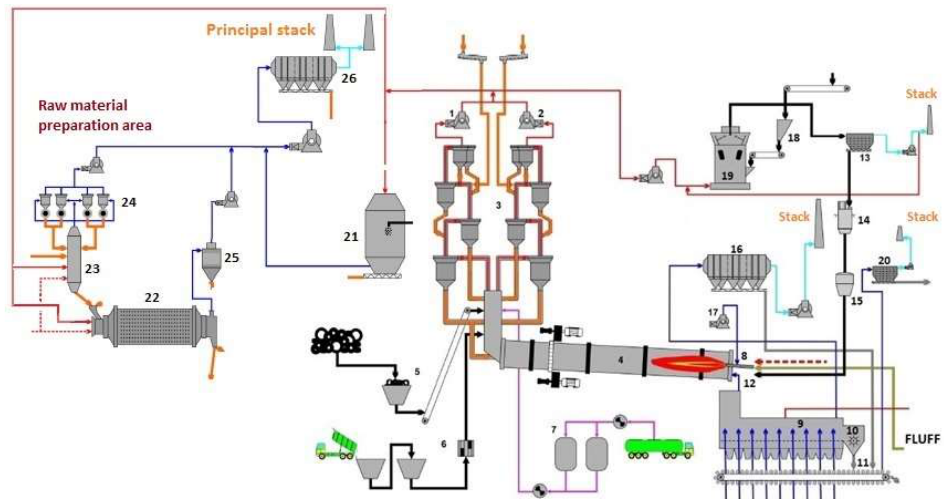
Figure 1. Simplified clinker diagram using raw materials and alternative fuels. 1. fan branch A; 2. fan branch B; 3. heat exchanger (preheater) for raw materials in the form of flour; 4. rotary kiln for clinker production; 5. supply used tires; 6. oil sludge (or sludge) feed system; 7. NOx reduction system; 8.burner; 9. grill cooler; 10.clincher crusher; 11.clincher carrier (conveyers); 12. prefiring; 13. charcoal dust bag filter; 14. milled coal silo; 15. dosing system; 16. grill cooling electrofilter; 17. primary air fan; 18. coal bunker; 19. Pfeiffer coal mill; 20. filter 2 cooler dust removal; 21. conditioning (wetting); 22.raw meal mill; 23. raw material drying tower; 24. dry tower dust removal cyclones; 25. cyclone dust removal mill; 26. Oven filter-mill.